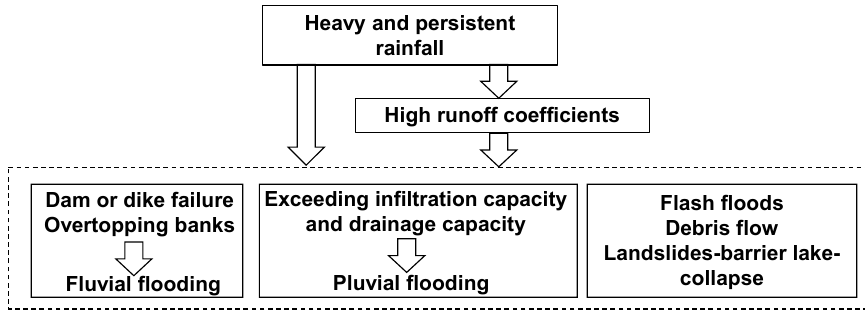
Figure 1. The causative mechanisms of extreme floods.